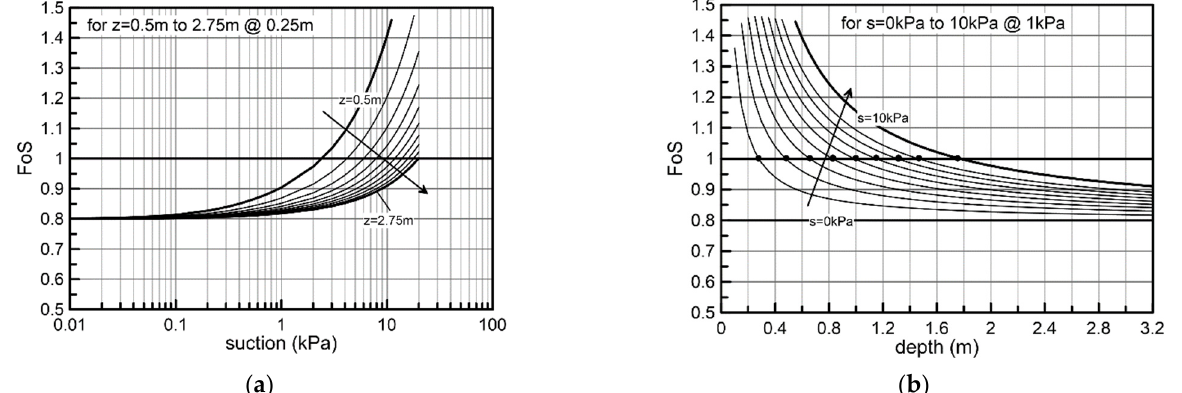
Figure 6. ( a ) Evolution of Factor of Safety (FoS) with suction for different slope heights; ( b ) evolution of FoS with slope height for different suction levels; results from a 2D mechanism (no lateral resistance).